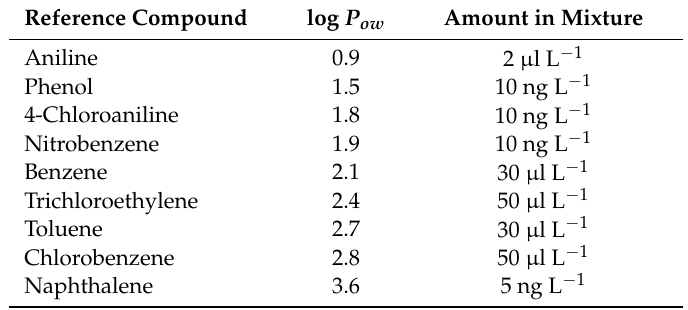
Table A1. Reference compounds’ log P ow values and composition of reference compound mixture.